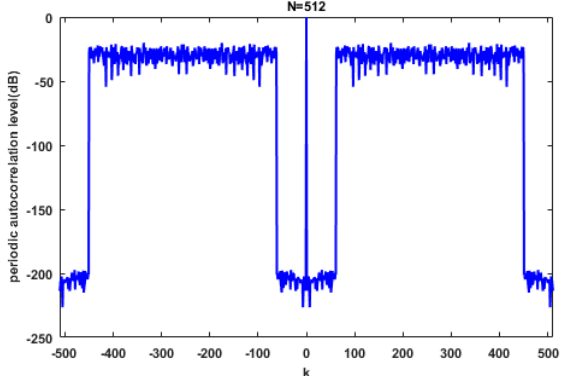
Figure 1. The autocorrelation levels of the unimodular sequence generated by the proposed PeWISL method. The sequence length is N = 512 and the weights are set as Equation (31).